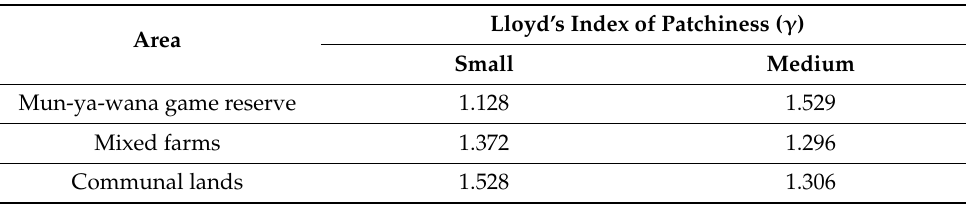
Table 2. Results of Lloyd’s Index of Patchiness per study area and rodent size-based group (small and medium) ( γ